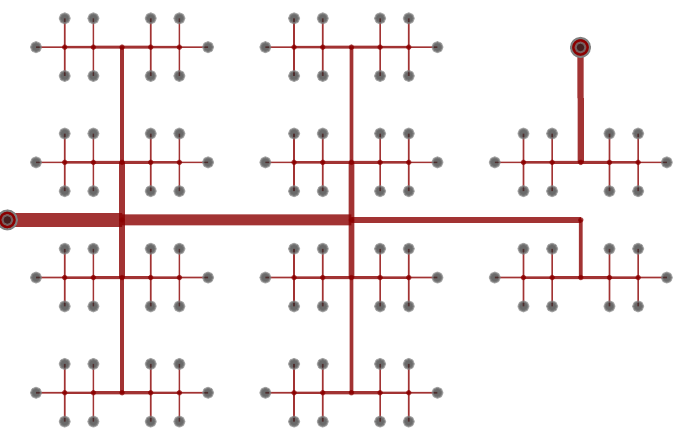
Figure A7. Generic separation scenario